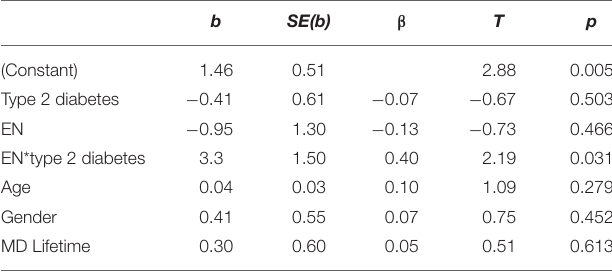
TABLE 3 | Regression on change in self-reported tension by emotional neglect, R 2 =